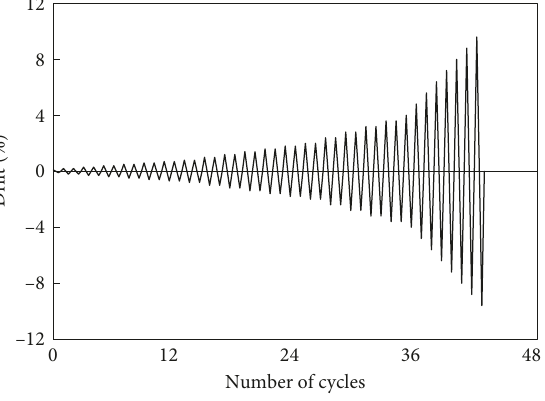
Figure 7: Loading